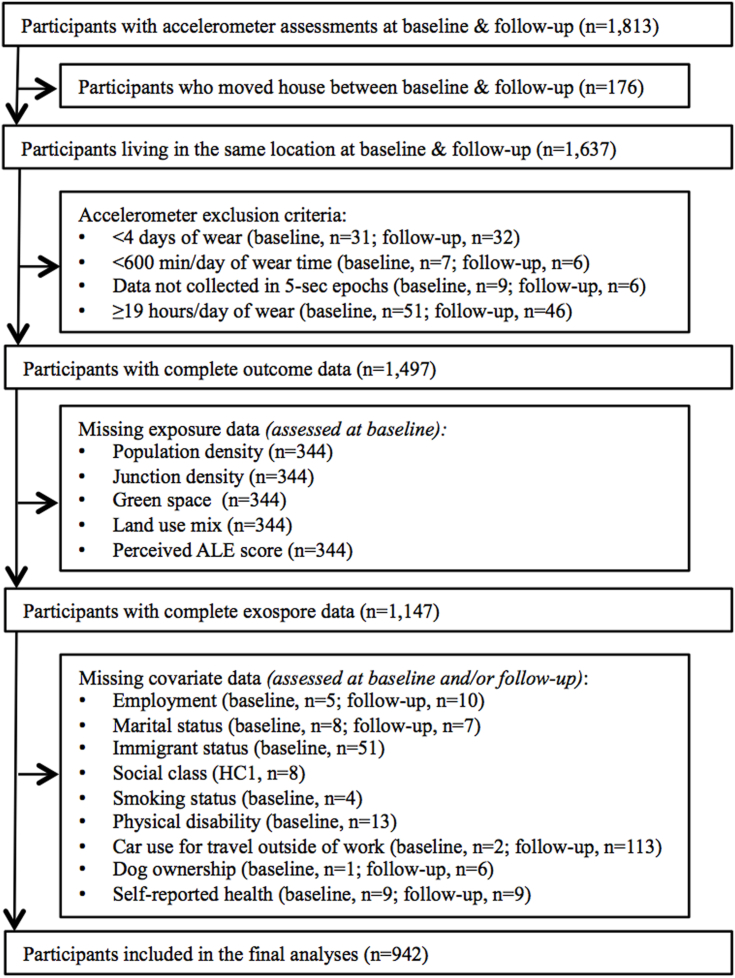
Selection of participants into the present study. Note: HC1, Health Check 1; ALE, active living environment; Since some participants had multiple applicable exclusion criteria, the sum of the individual excluded observations is not equivalent to the total number of excluded observations.